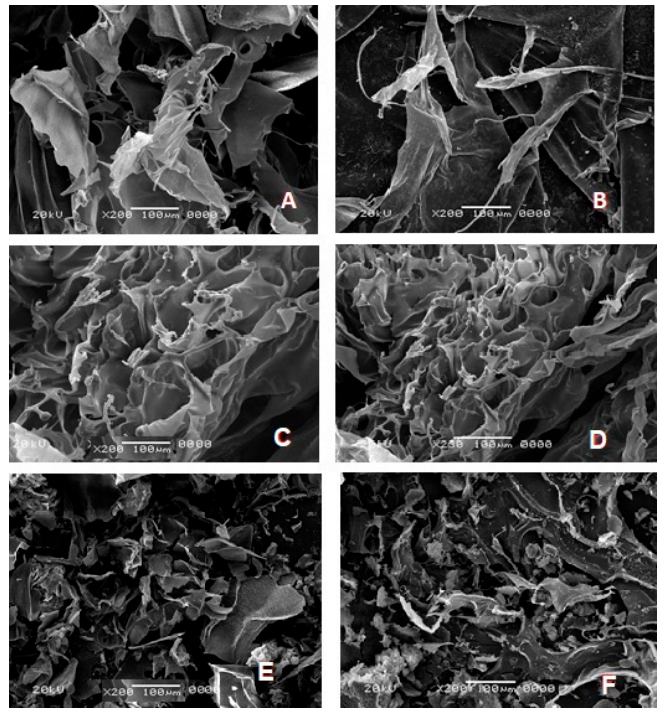
Figure 3. Scanning electron micrographs of ( A ) Unloaded 5:5 CH/Alg PEC—based insert ( B ) Fluconazole 5:5 CH/Alg PEC ( C ) Unloaded 5:5 CH/XG PEC—based insert ( D ) Fluconazole 5:5 CH/XG PEC ( E ) Unloaded 5:5 CH/Carb PEC—based insert ( F ) Fluconazole 5:5 CH/Carp PEC (×200).